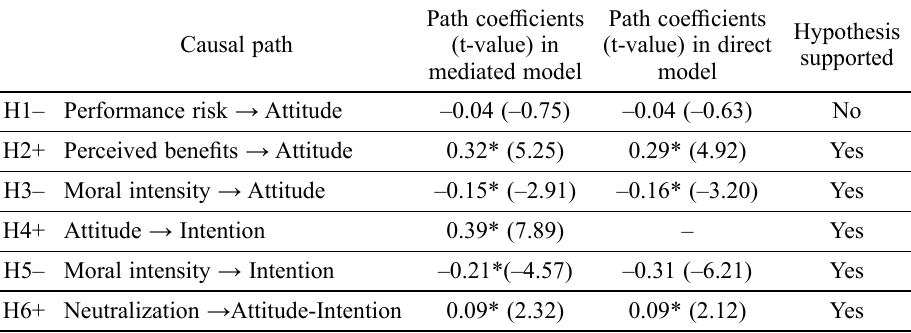
Table 2. Hypotheses testing and